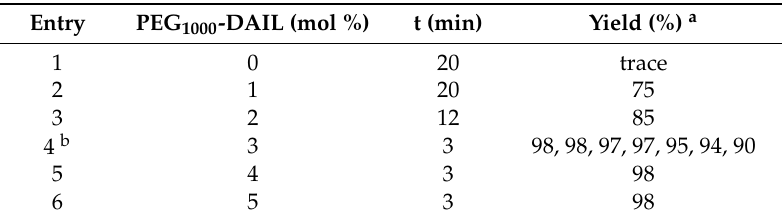
Table 2. PEG 1000 ‐ DAIL ‐ catalyzed synthesis of bis(indolyl)methanes ( 3a – 3x ).